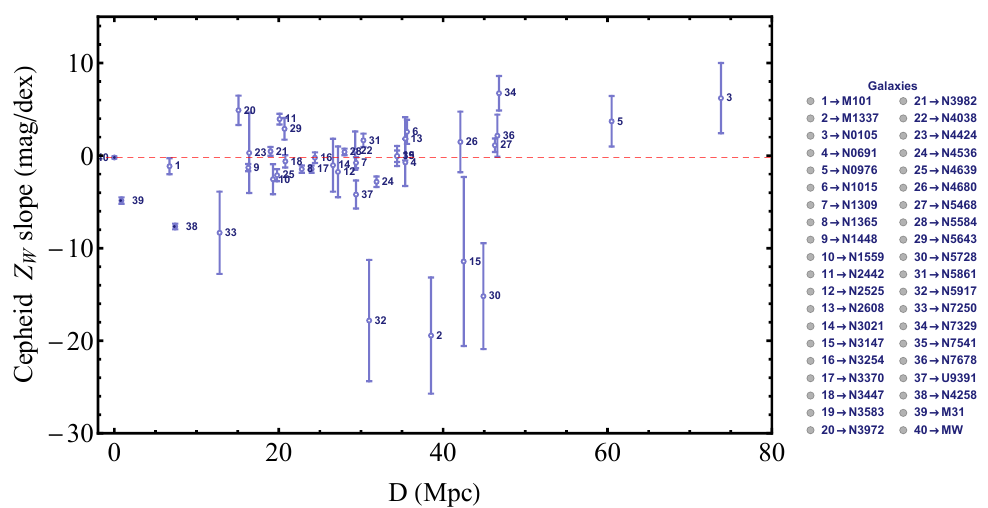
Figure 2. Independently fitted metallicity slopes Z W , i in terms of the distance of the Cepheid host. Clearly, the spread of many points is larger than the corresponding uncertainties indicating either inhomogeneities of the sample or underestimation of the uncertainties. In fact, there seems to be a trend of most | Z W , i | absolute slopes being larger than the corresponding slope of the Milky Way (MW) (below the dotted line). The dotted line corresponds to the best-fit value of Z W = − 0.21 in the context of the baseline SH0ES analysis as shown in Table